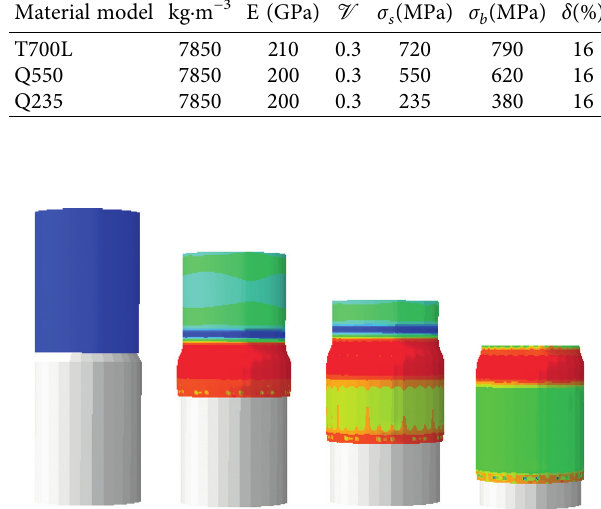
Figure 5: Deformation process of constant resistance energy-ab- sorbing device.